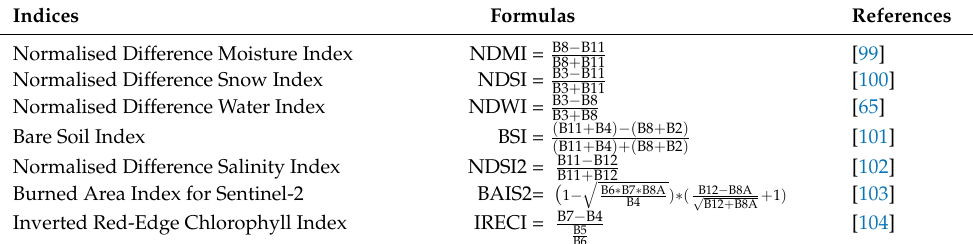
Table A2. List of additional spectral indices tested and their corresponding formulas.